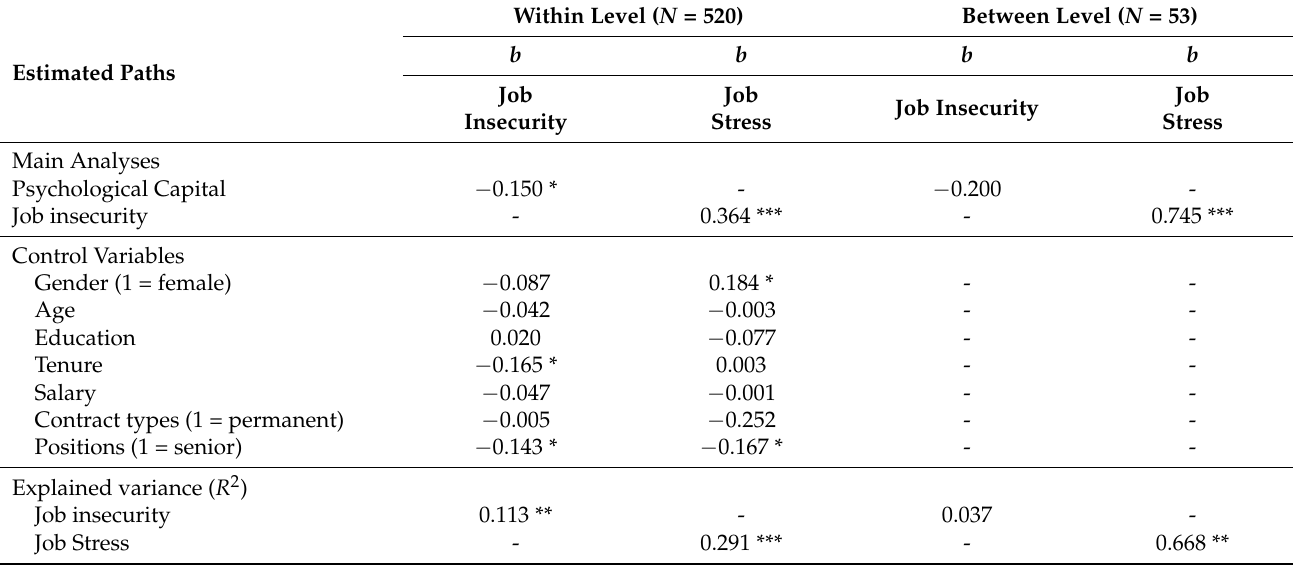
Table 4. Multilevel structural equation modeling (MSEM) analyses.